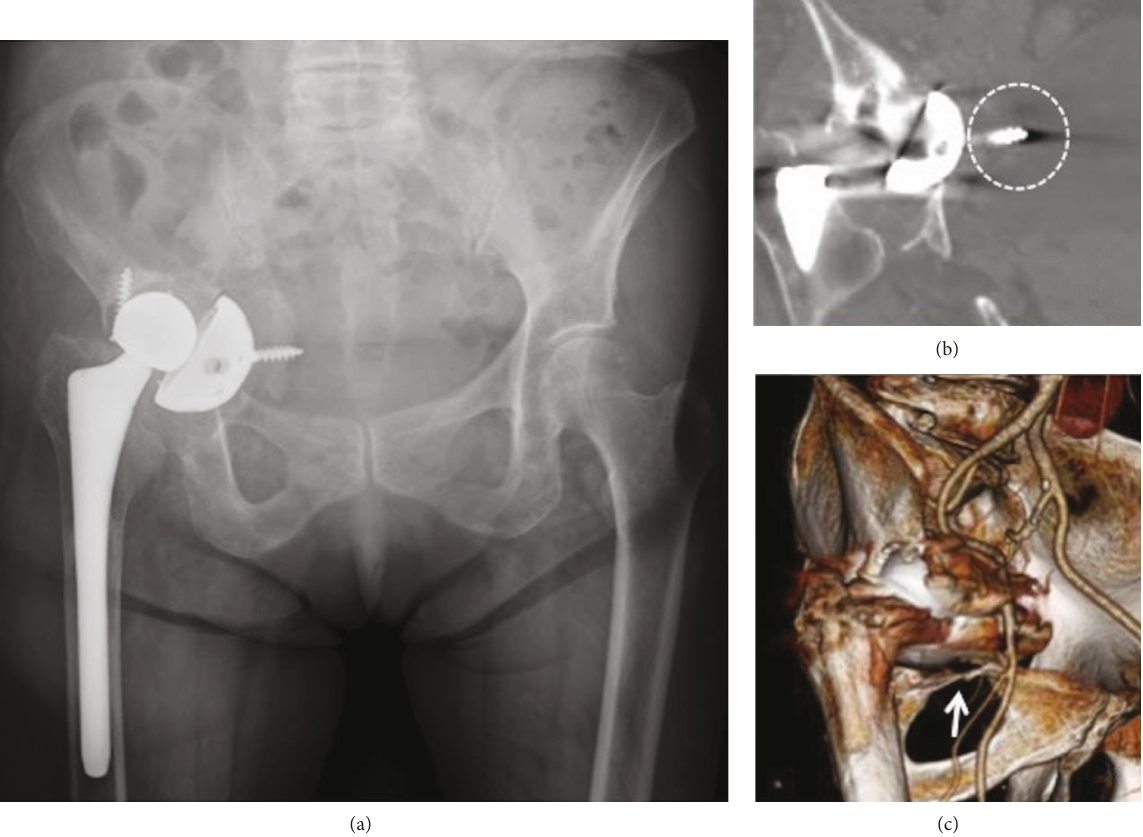
Figure 1: Preoperative plain radiographic (a) and computed tomographic (b, c) images of the pelvis. Coronal computed tomographic image shows a screw pressing the bladder wall (white dotted circle). White arrow indicates a fracture of the superior aspect of the obturator